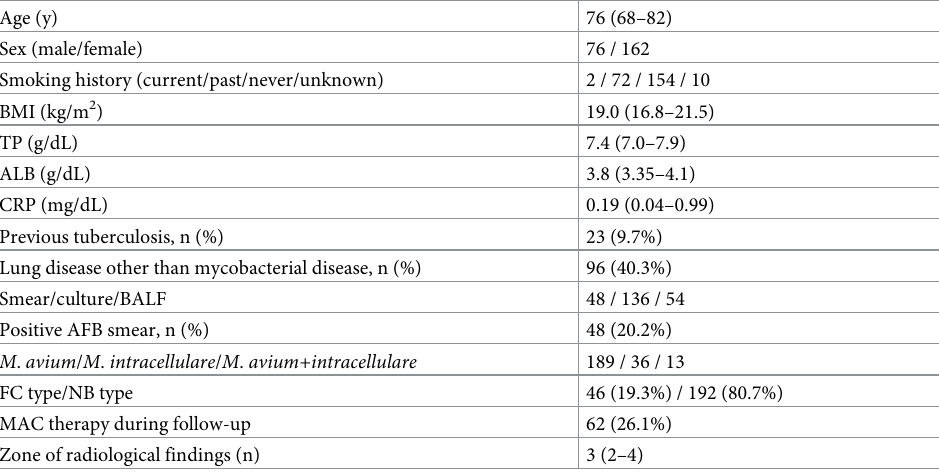
Table 1. Baseline characteristics of pulmonary MAC patients (n = 238).